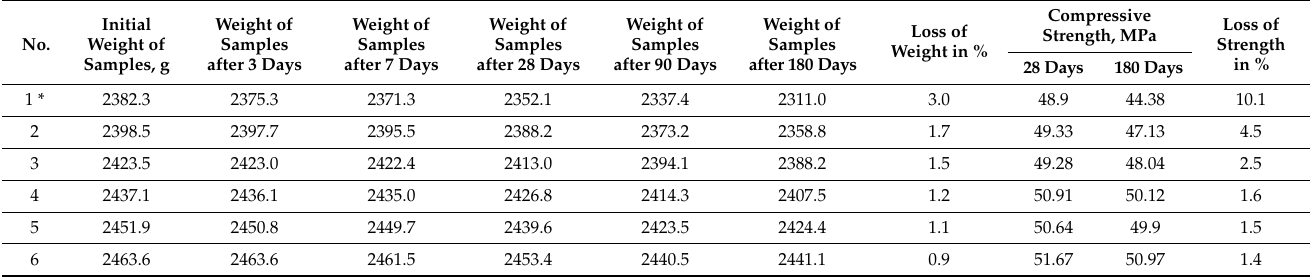
Table 17. Results of tests of RHC compositions containing MCU-95 for frost resistance in 10% NaCl